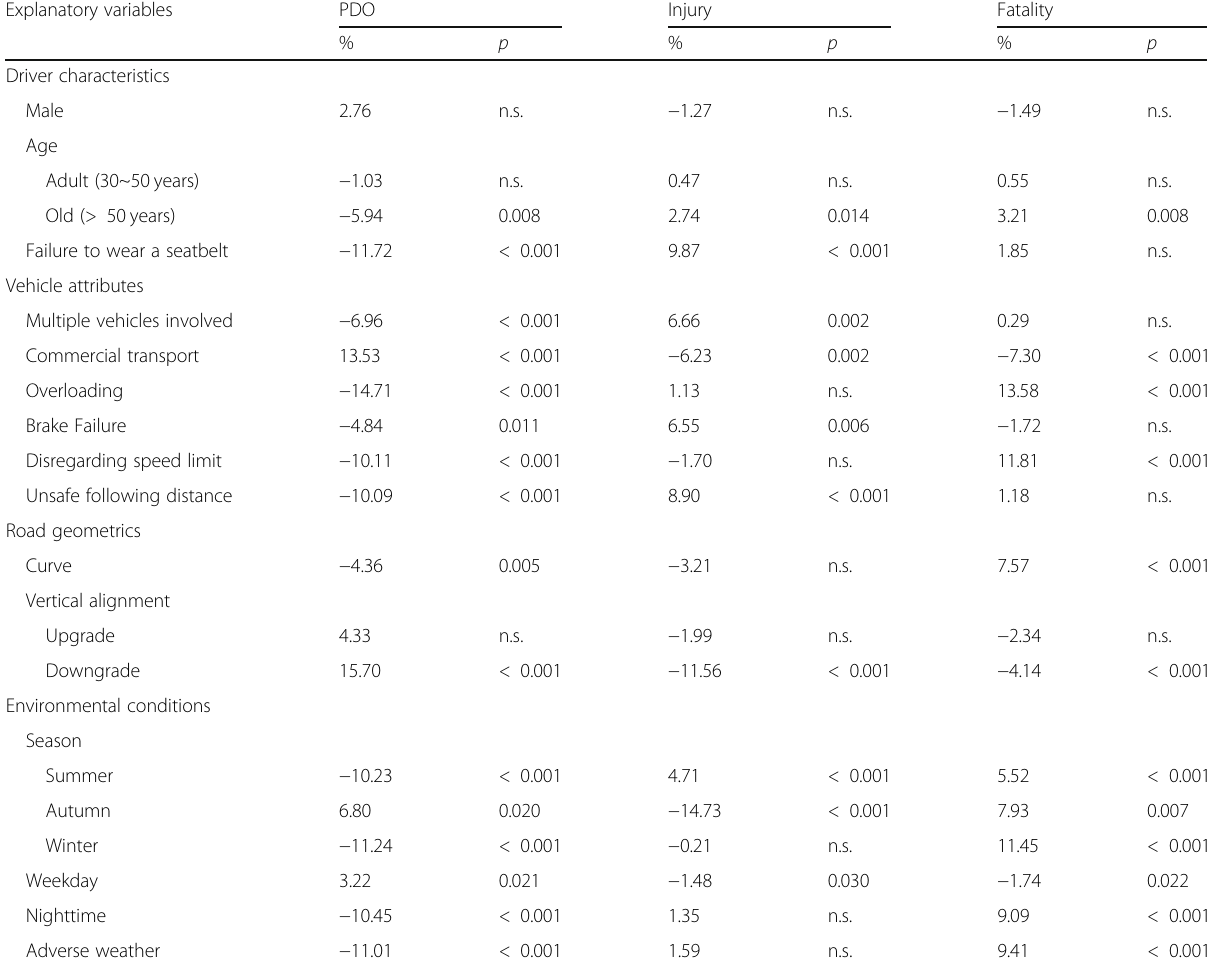
Table 3 Average pseudo-elasticities for the partial proportional odds model Explanatory